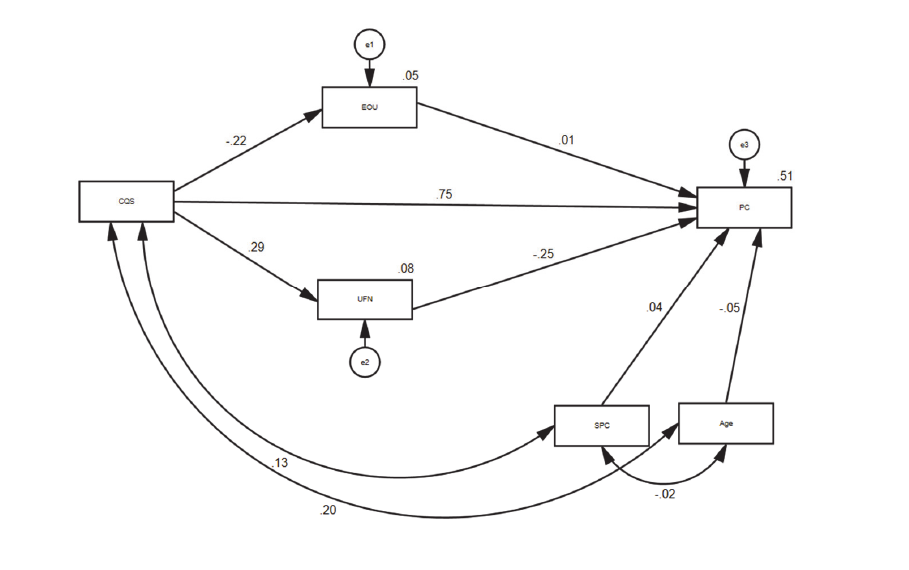
Fig. 2. Path model